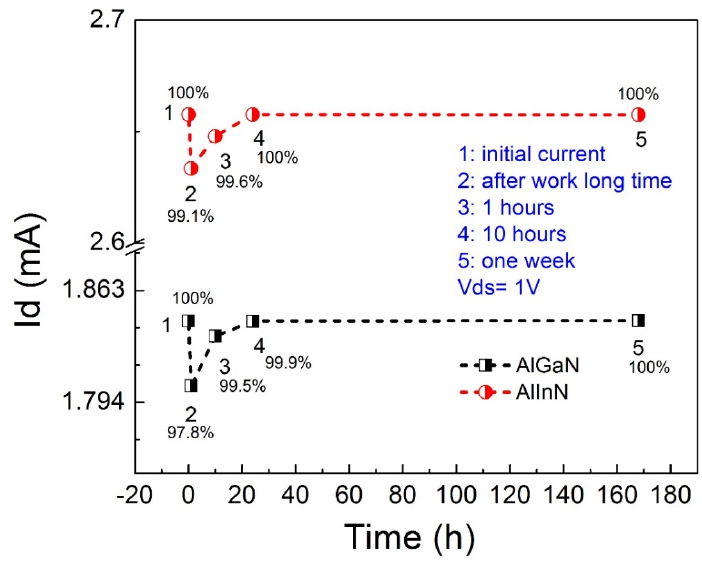
Figure 7. For AlGaN/GaN and AlInN/GaN structure devices, their performance degradation and the recovery condition after working in a solution for a long